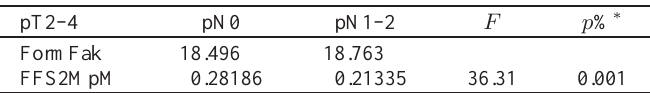
Table 7 p53 positive tumours with and without lymph node metastases